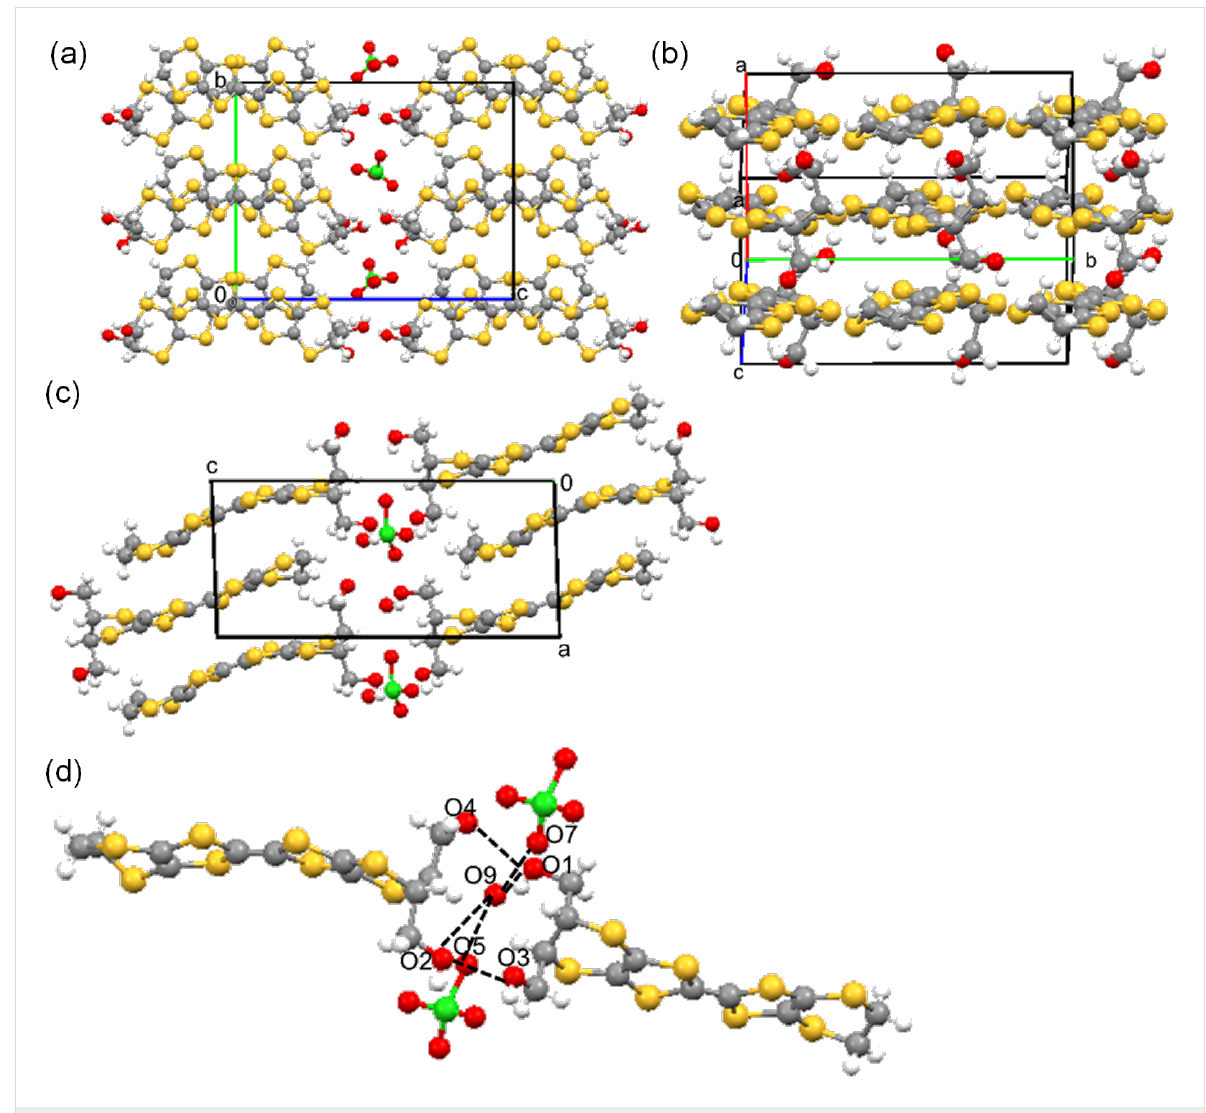
Figure 3: Crystal structure (a) viewed along the a -axis, (b) donor arrangement, (c) viewed along the b -axis, and (d) intermolecular hydrogen bond contacts for chiral charge transfer salt α '-[( R,R )- 2 ] 2 ClO 4 (H 2 O). The calculated hydrogen bonds are as follows; r (O1···O4) = 2.67(3), r (O1···O9) = 3.00(3), r (O2···O3) = 2.67(2), r (O2···O9) = 2.85(3), r (O5···O9) = 2.62(6), and r (O7···O9) = 2.90(6)